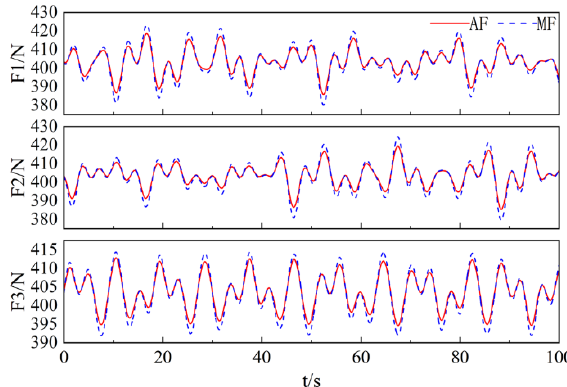
Figure 11. Tractive force of each drive support chain under the static